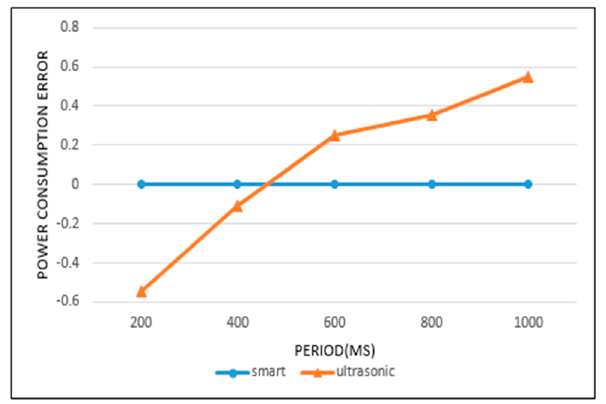
Figure 17. Power consumption error of ultrasonic sensor. Sensors 2019 , 19 , x